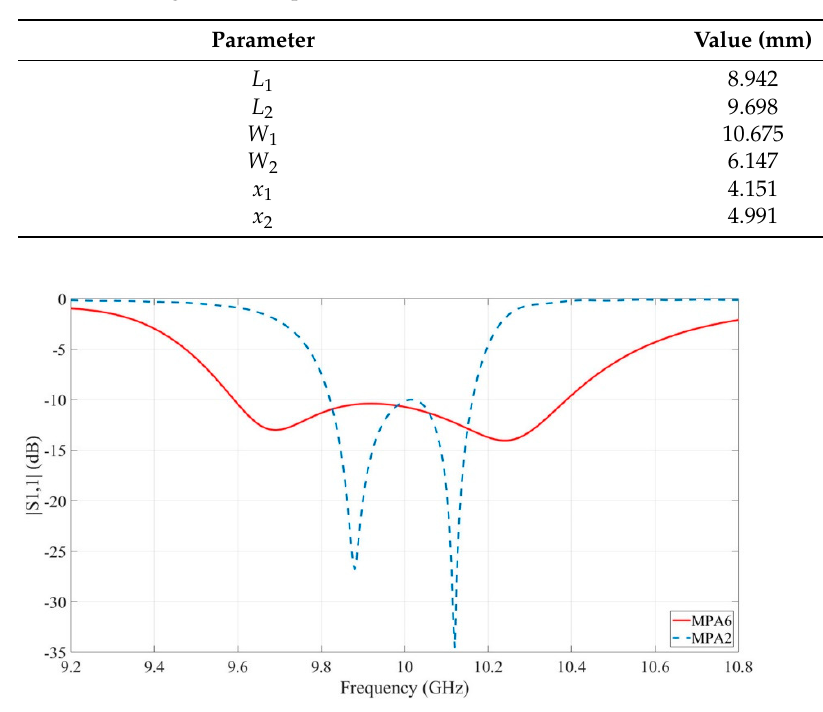
Figure 13. Simulated reflection coefficient for MPA2 and MPA6.